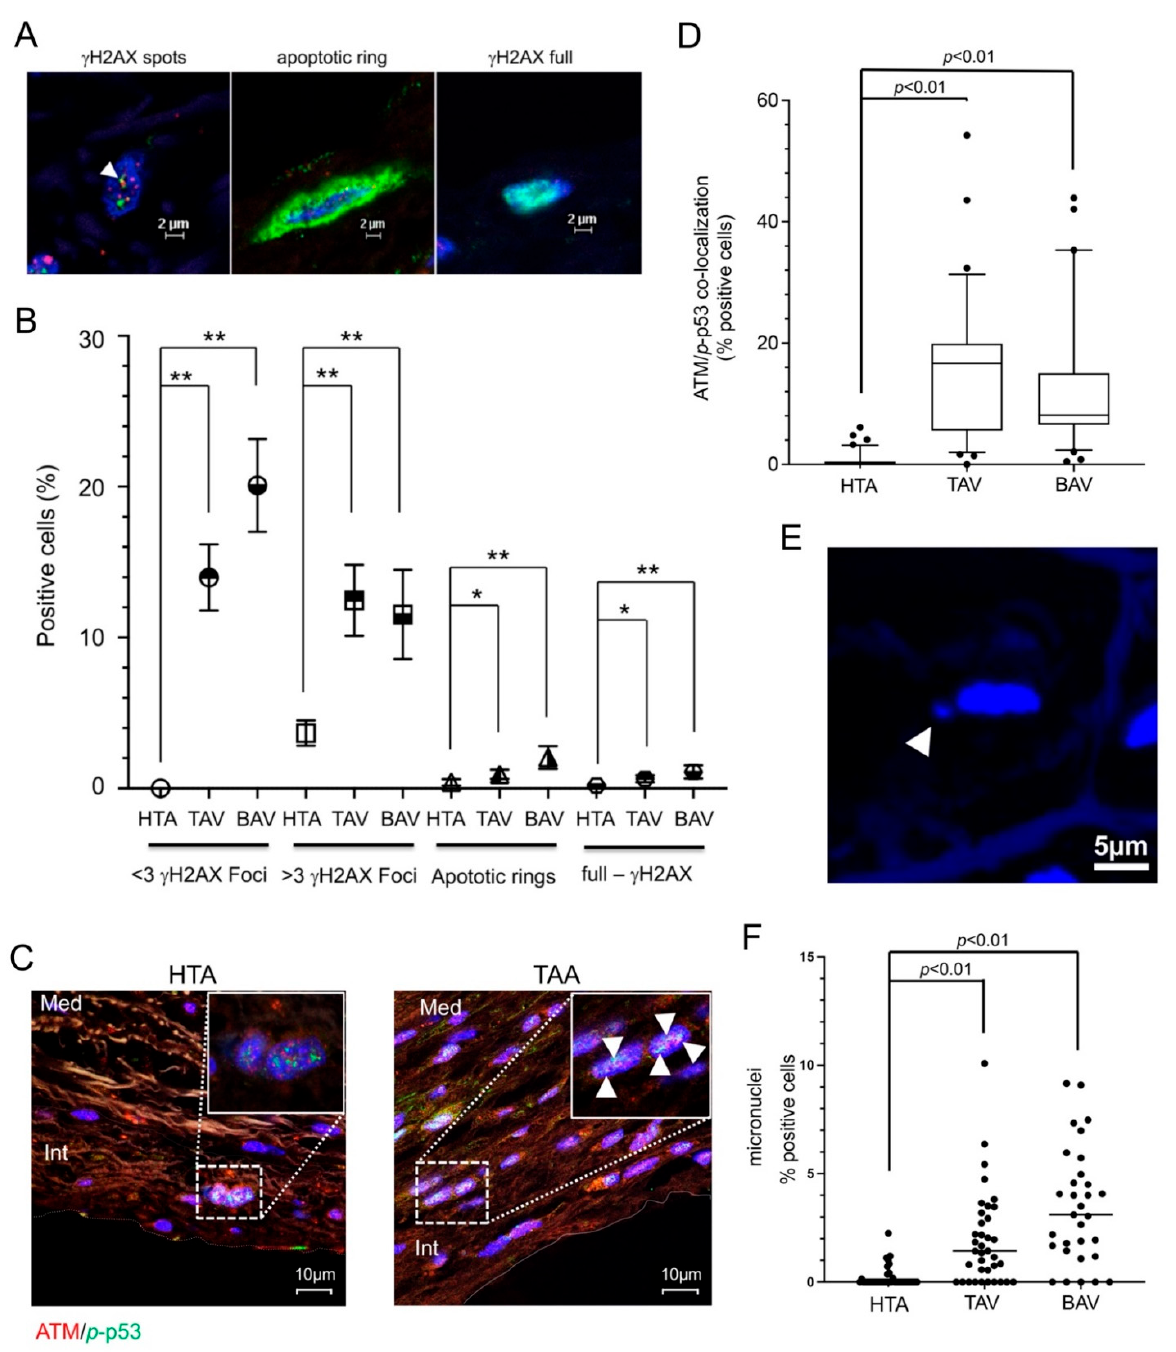
Figure 3. DNA damage, cell senescence and cell death measured by γ H2AX/ATM/ p -p53 staining. Hypoxic stress in aneurysm sections leads to DNA damage and cellular senescence measured by γ H2AX IF-staining. ( A ) Representative images of γ H2AX spots (white arrow, left image), apoptotic ring (middle image) and γ H2AX full staining (right image) detected in aortic and aneurysmal specimens. Green, γ H2AX; blue, cell nuclei (DAPI). Scale bar, 2 µm. ( B ) Statistical calculations of different amounts of γ H2AX foci (<3 foci and >3 foci), apoptotic rings, and full- γ H2AX staining measured in HTA ( n = 41) and both TAA groups, TAV ( n = 109) and BAV ( n = 65). n of counted cells: HTA, 5707; TAV, 19,421 cells; and BAV, 13,530 cells. * p < 0.05; ** p < 0.01. ATM and phosphorylated (p) -p53 expression was measured by IF staining ( C , D ). ( C ) Representative images of ATM protein (red) and p -p53 (green) expression stained by IF. Colocalizations were found in TAA samples (white arrows). Blue, cell nuclei (DAPI). Med, media; Int, intima. Scale bar, 10 µm. ( D ) Statistical analysis for ATM and p -p53 protein colocalization in HTA, compared to TAA-TAV and TAA-BAV